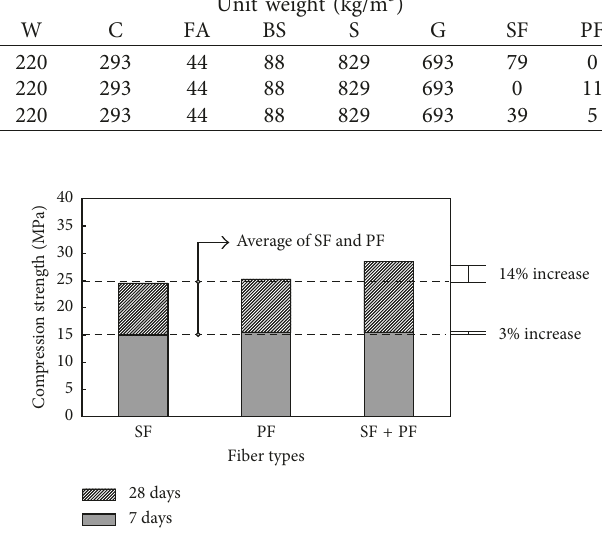
Figure 4: Influence of fiber combination on compressive strength of concrete mixtures (the dotted line expresses the average value of SF and PF).